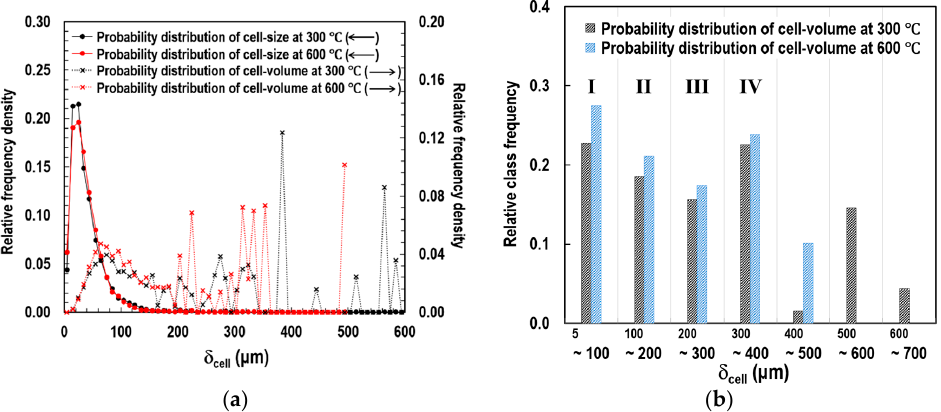
Figure 5. Probability distributions of cell size and volume: ( a ) relative frequency densities of δ cell and V cell , and ( b ) relative class frequency of V cell .